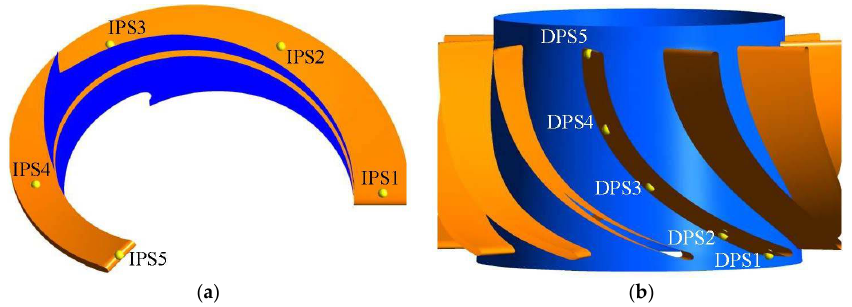
Figure 3. Data collection sites. ( a ) Impeller; ( b ) diffuser.